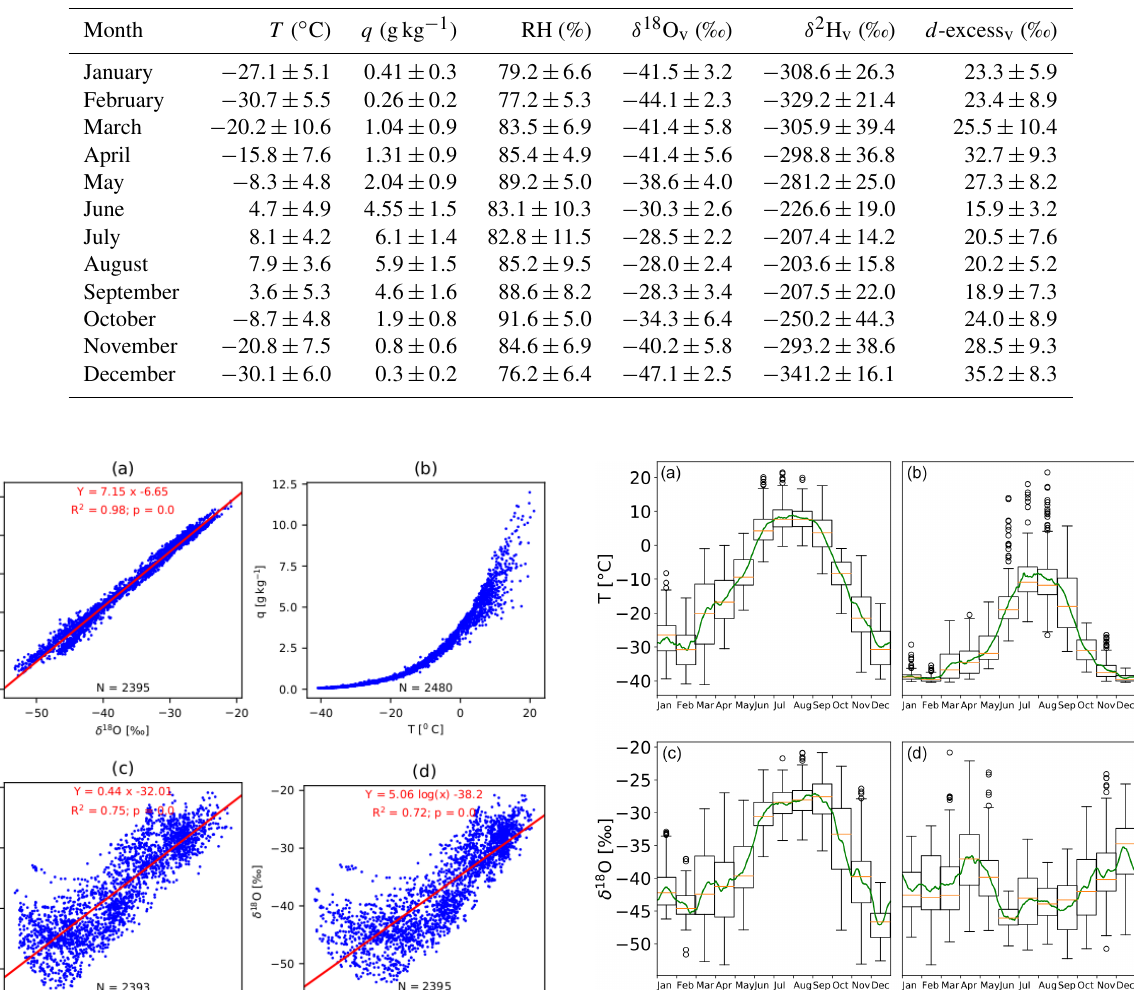
Table 2. Monthly averaged values and standard deviations for the period 1 July 2015 to 1 July 2017 for air temperature ( ◦ C), specific humidity q (kg − 1 ), relative humidity (%), δ 18 O v (‰), δ 2 H v (‰) and d -excess v (‰).